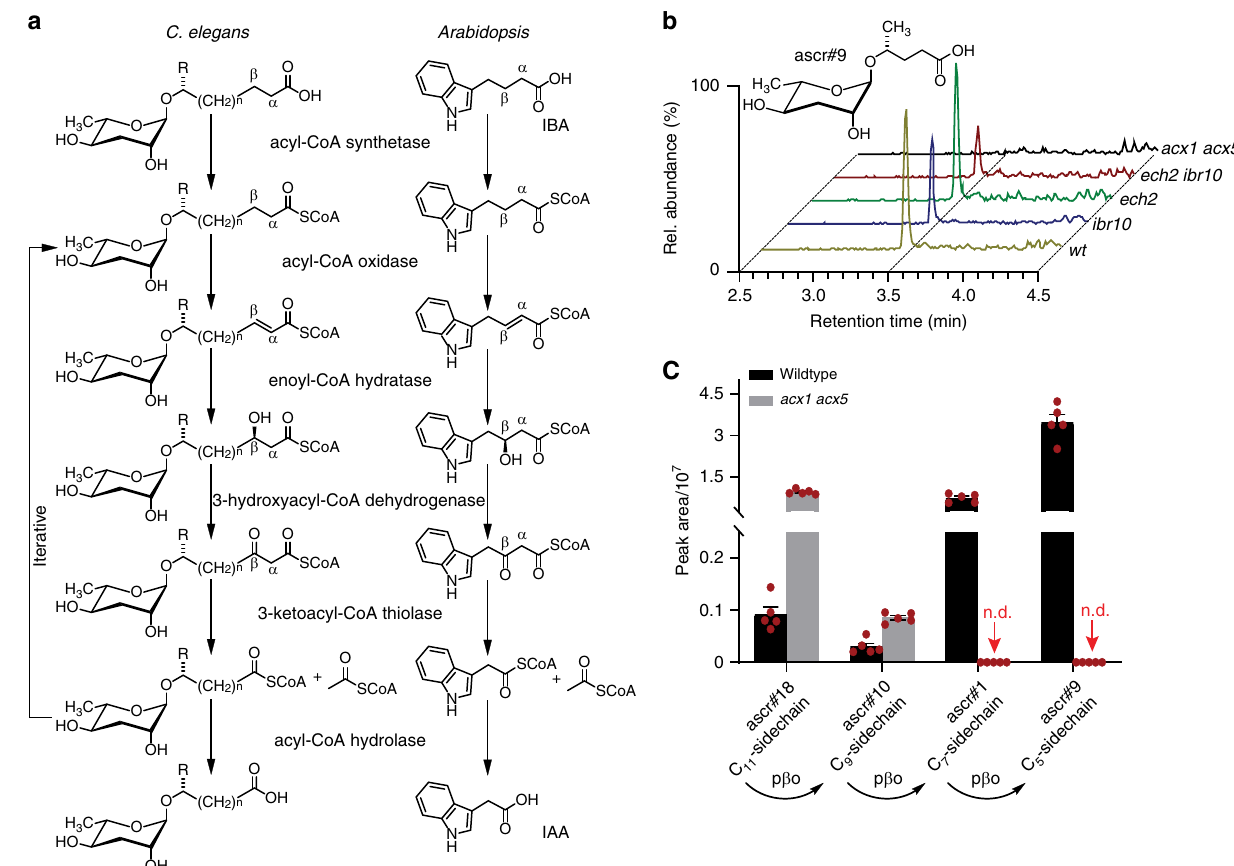
Fig. 3 Arabidopsis metabolizes ascr#18 via conserved peroxisomal β -oxidation. a Comparison of peroxisomal β -oxidation pathways and associated enzymes involved in the conversion of indole-3-butyric acid (IBA)-to-indole acetic acid (IAA) in Arabidopsis and ascaroside biosynthesis in C. elegans . b LC- MS analysis of Arabidopsis seedlings treated with 1 µ M ascr#18 for 24 h before sample extraction, comparing ascr#9 production in wildtype and ibr10, ech2 , ech2 ibr10 , or acx1 acx5 mutants. c Comparison of ascaroside abundances in Arabidopsis wildtype and acx1 acx5 roots treated with 1 µ M ascr#18. Data are mean ± SEM ( n = 5); n.d. = not detected. Source data are provided as a supplemental data fi le. Source data are provided as a source data fi